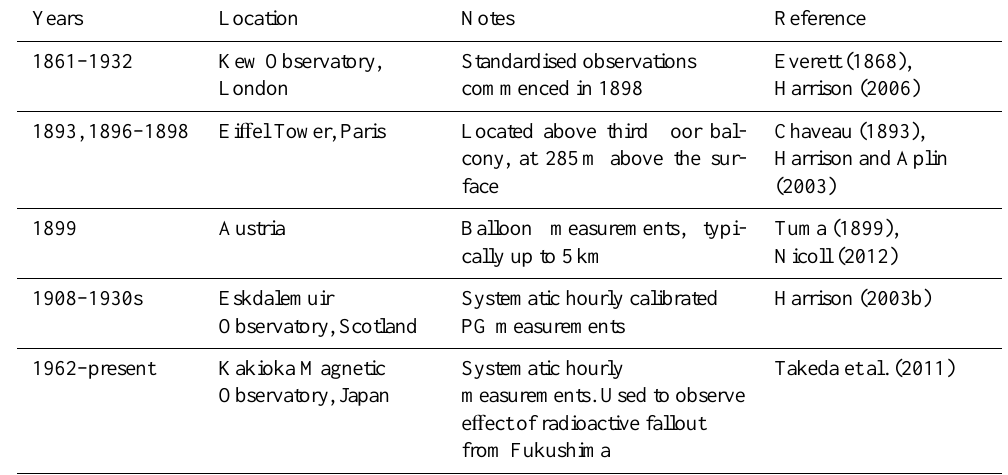
Table 3. Use of the water dropper equaliser in atmospheric electricity